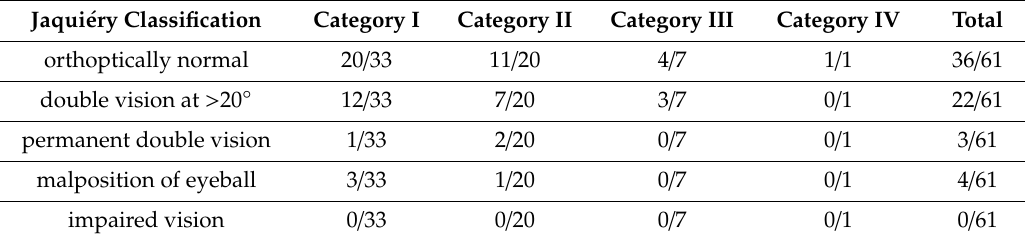
Table 2. Postoperative ophthalmologic and orthoptic assessment in 61 patients.